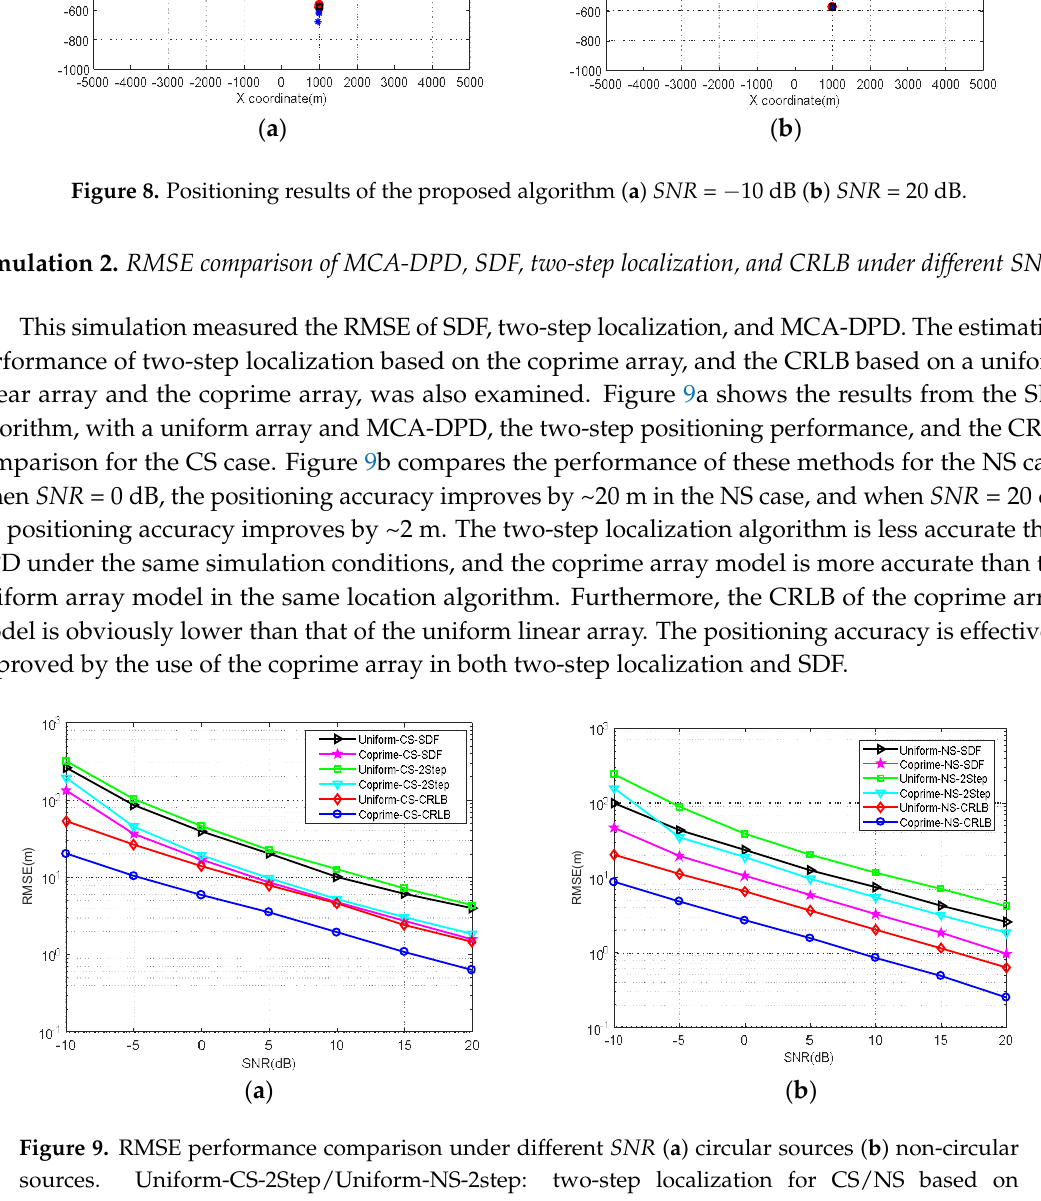
Figure 7. Trajectory of the station movement related to the target sources.